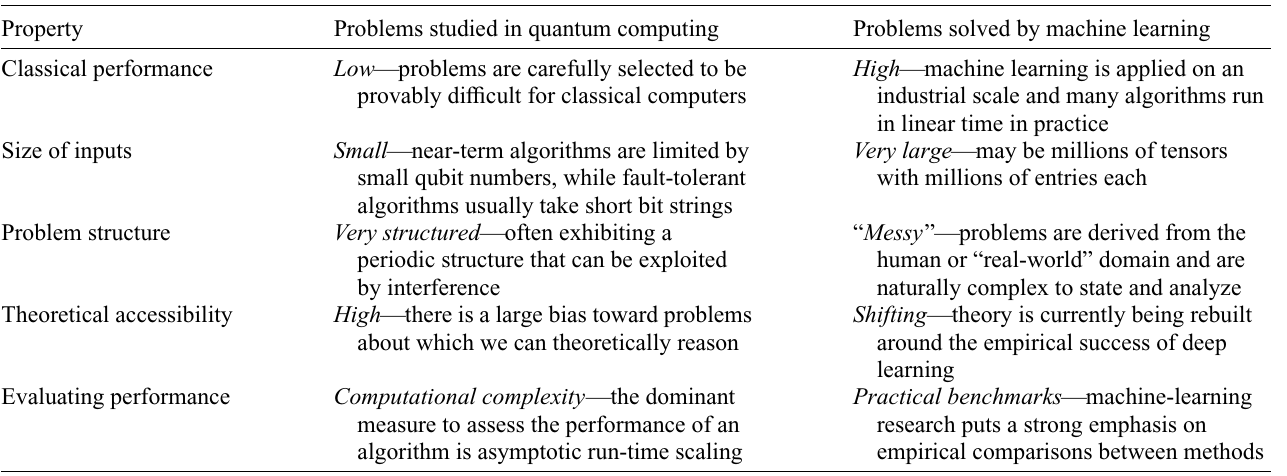
TABLE I. A comparison of typical properties of problems studied in quantum computing versus problems solved by machine- learning algorithms. Looking at this table, it is no surprise that quantum machine learning is a tough candidate for applications with a quantum